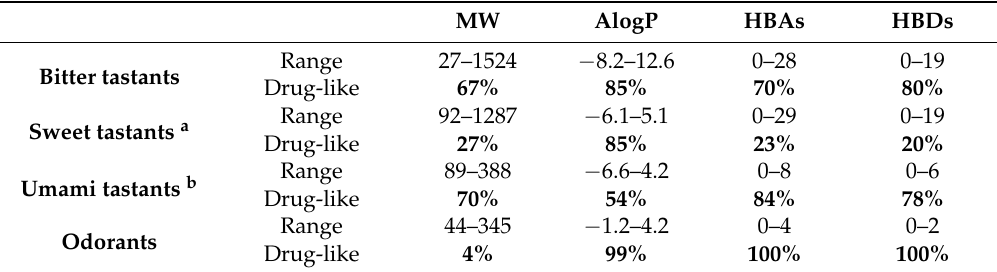
Table 1. Physicochemical property ranges and drug-likeness percentage of flavour molecules. found for approved DrugBank compounds. MW AlogP HBAs HBDs Bitter tastants